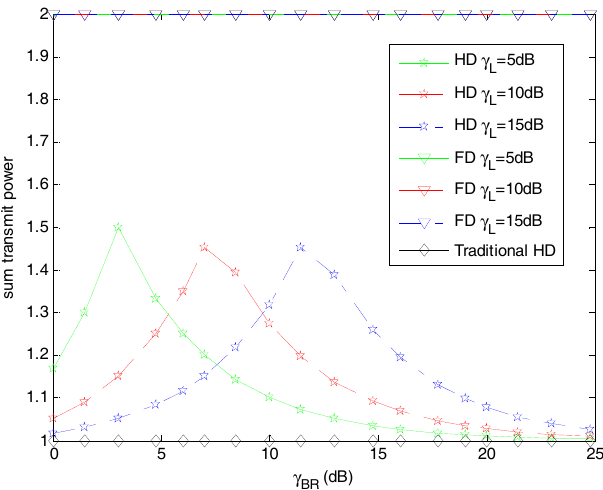
Figure 6. Sum transmit power consuming with different SINR from the base station to the D2D relay.